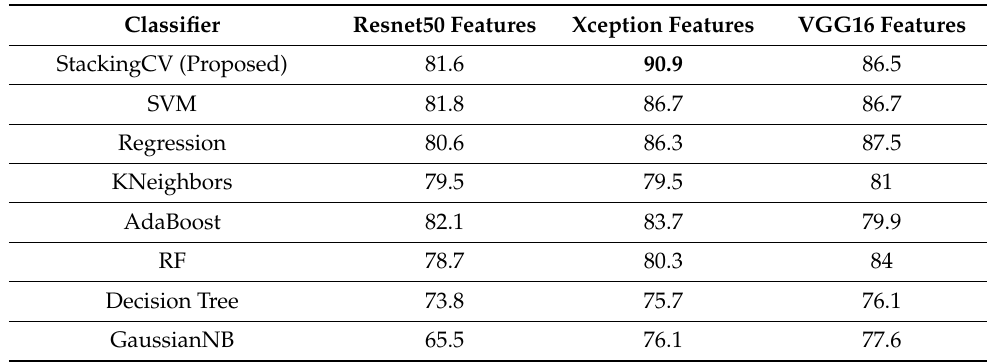
Table 5. The comparative performance based on the accuracy.